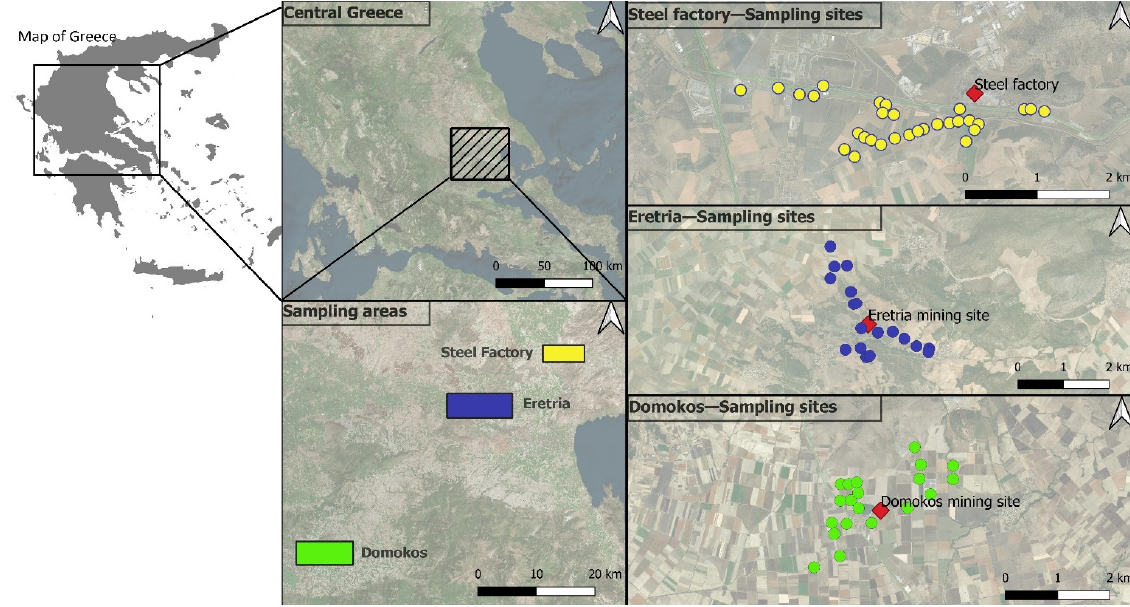
Figure 1. Map of the locations of the three study areas and the sampling points in central Greece.